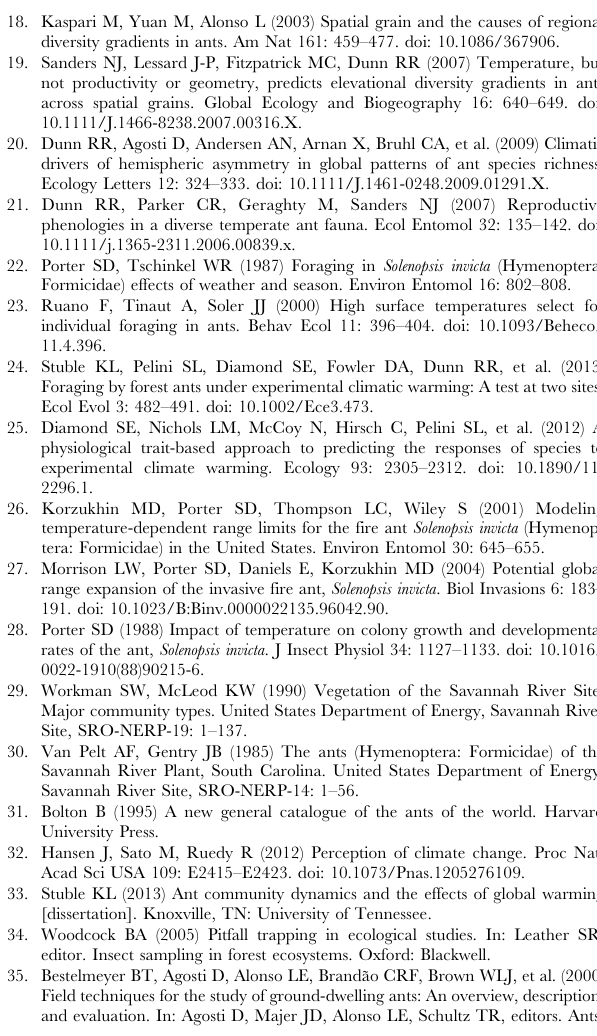
Table S1 Relative activity-densities of Duke Forest ant species among chamber treatments and